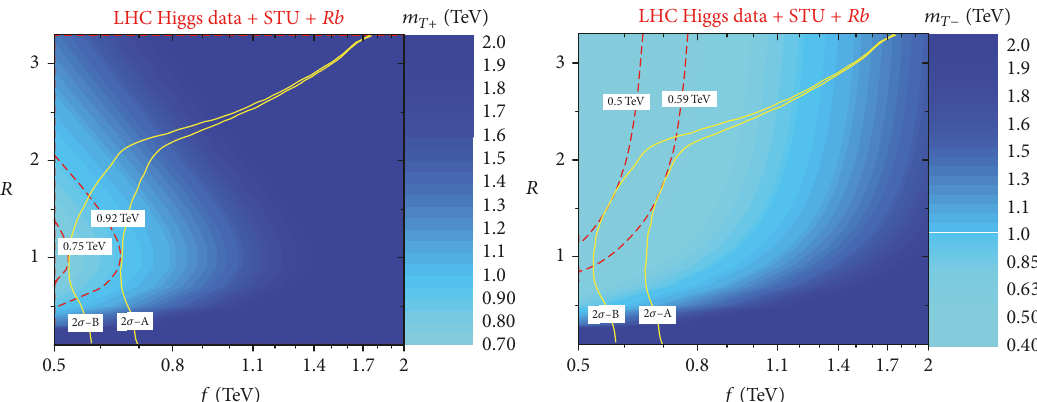
Figure 3: Exclusion limits on the top partner masses on the 𝑅 ∼ 𝑓 plane at 2𝜎 confidence level for Case A and Case B, where the parameter 𝜅 is marginalized over.